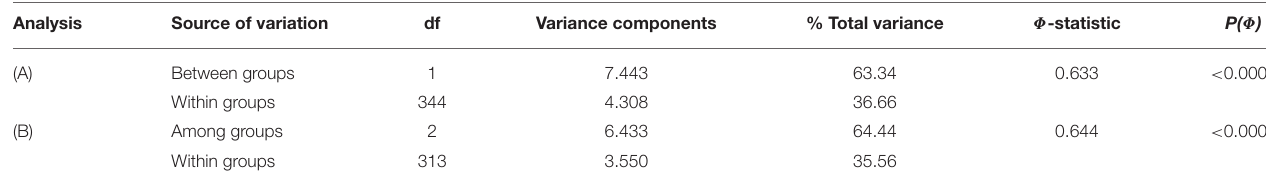
TABLE 2 | Analysis of molecular variance for the partitioning of microsatellite diversity of Croatian common bean accessions classified into (A) two as well as (B) three groups according to model-based cluster analysis and phaseolin type.